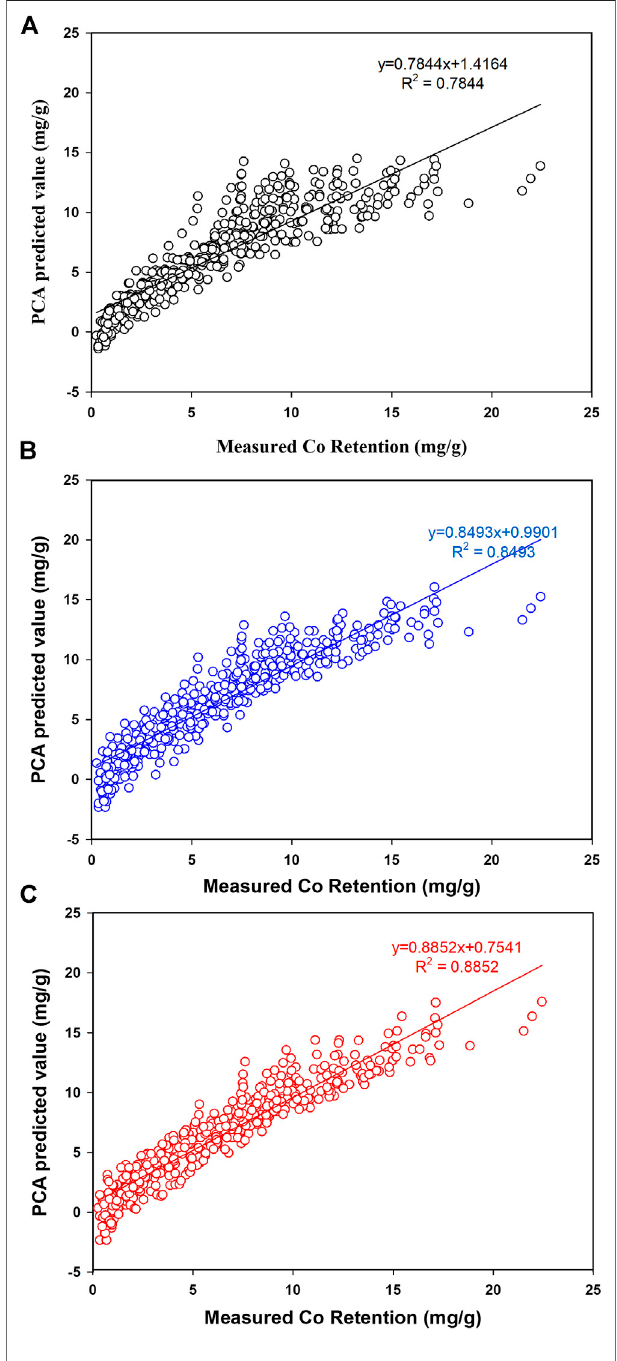
FIGURE 6 | Prediction of Co retention by PCA. A: Linear terms, B: Quadratic terms, C: Interaction terms.